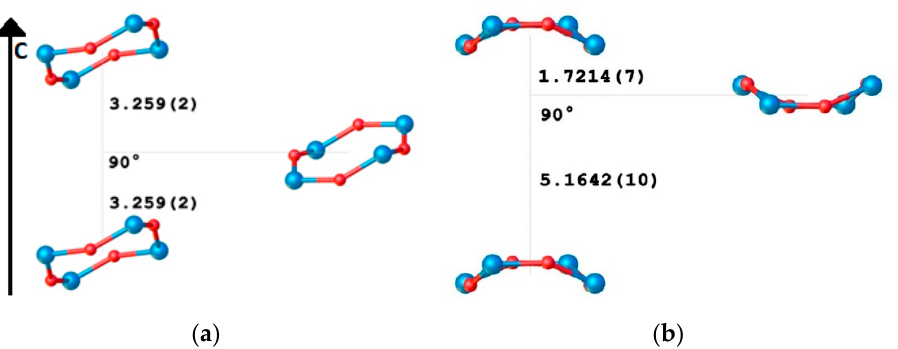
Figure 4. Mutual position of adjacent molecules in the low-temperature ( a ) and high-temperature ( b ) phases. Image plane equal to the ac plane of the unit cell. Hydrogen and carbon atoms are omitted for clarity. Color code: silicon—blue, oxygen—red.